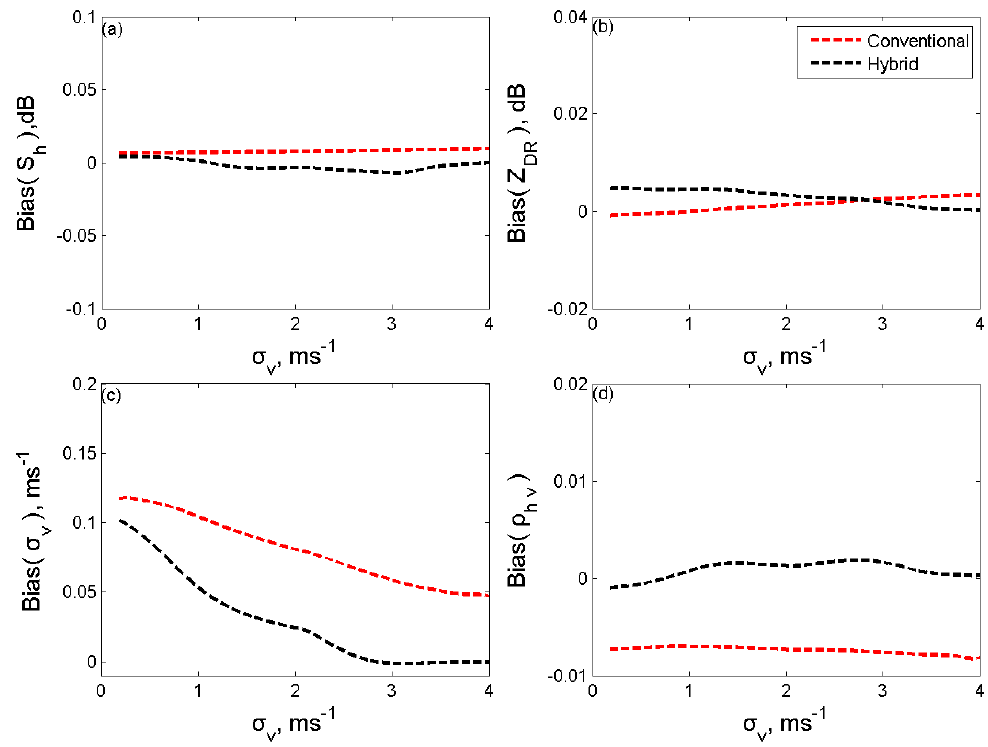
Figure 15. Comparison of bias from conventional estimator and hybrid estimator at SNR = 10 dB. ( a ) S h ; ( b ) Z DR ; ( c ) σ v ; and ( d ) ρ hv . The radar data used here are the same as Figure 10.